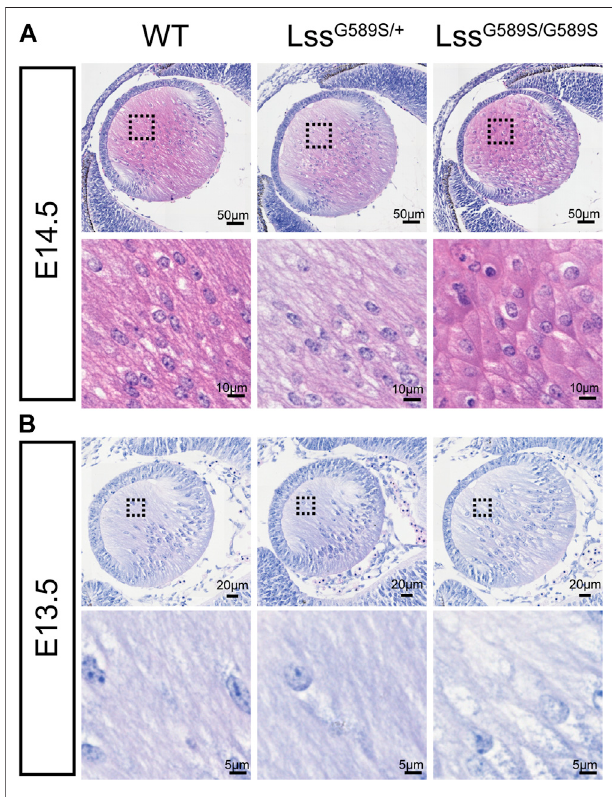
FIGURE5| Morphologyof fi bercellsinembryoniclensofLss G589S/G589S mice. (A) Morphology of fi ber cells stained with hematoxylin and eosin in embryonic lens of WT, Lss G589S/+ , and Lss G589S/G589S mice at E14.5. Scale bar: 50 μ m. The enlargement is the magni fi cation of the boxed inset shown in the upper panel. Scale bar: 10 μ m. (B) Morphology of fi ber cells in embryonic lens of WT, Lss G589S/+ , and Lss G589S/G589S mice at E13.5. Scale bar: 20 μ m. The enlargement is the magni fi cation of the boxed inset shown in the upper panel. Scale bar: 5 μ m.